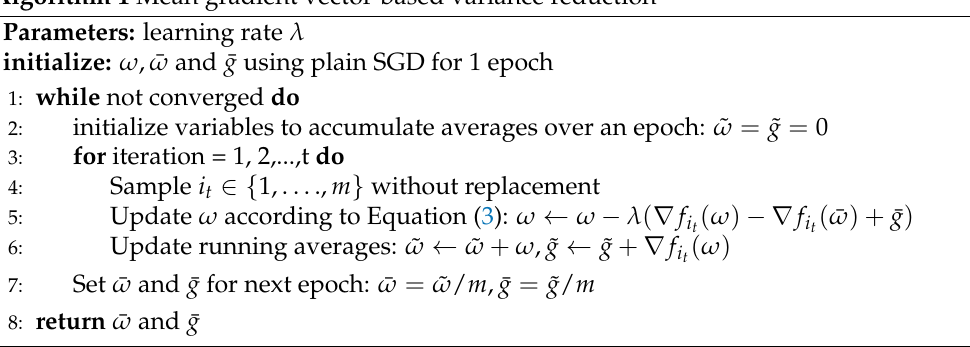
Algorithm 1 Mean gradient vector-based variance reduction Parameters: learning rate